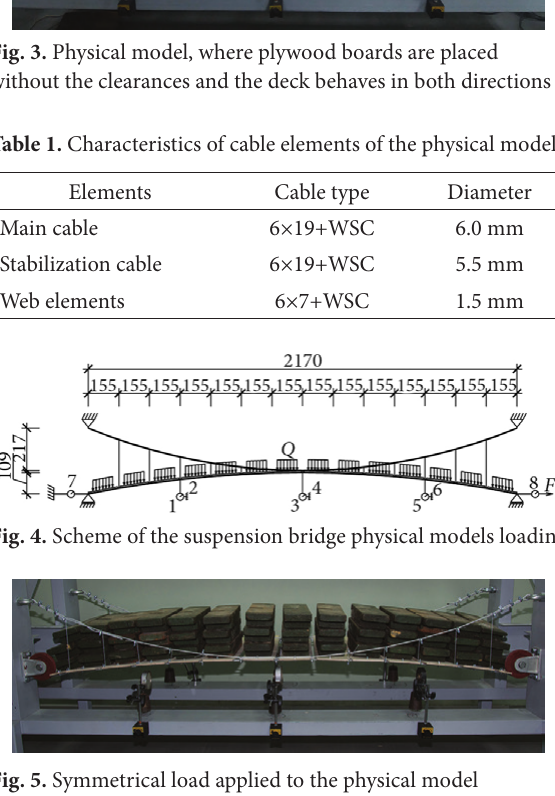
Fig. 5. Symmetrical load applied to the physical model of prestressed suspension bridge